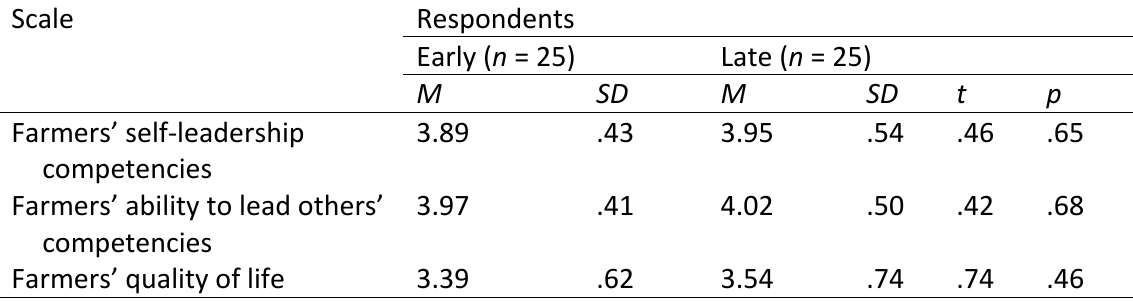
Independent Samples t-test for Equality of Means on Scale Scores of Construct between Early and Late Respondents